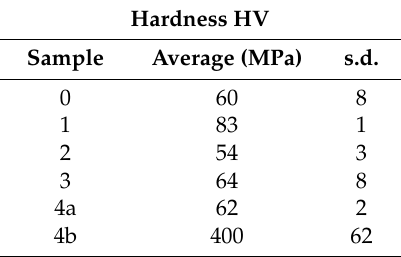
Table 6. Vickers hardness values of the copper samples.